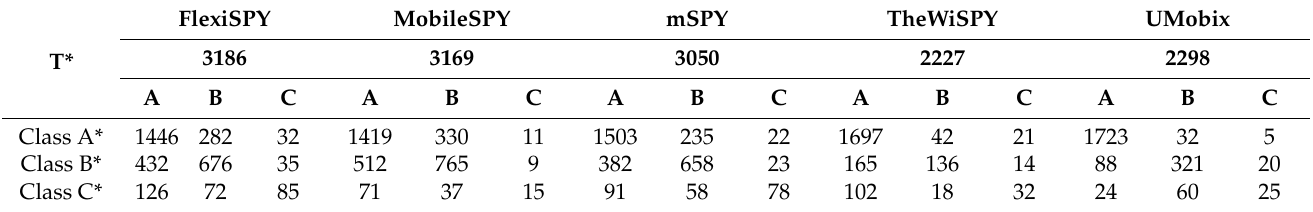
Table 12. Multi-class confusion matrix results.